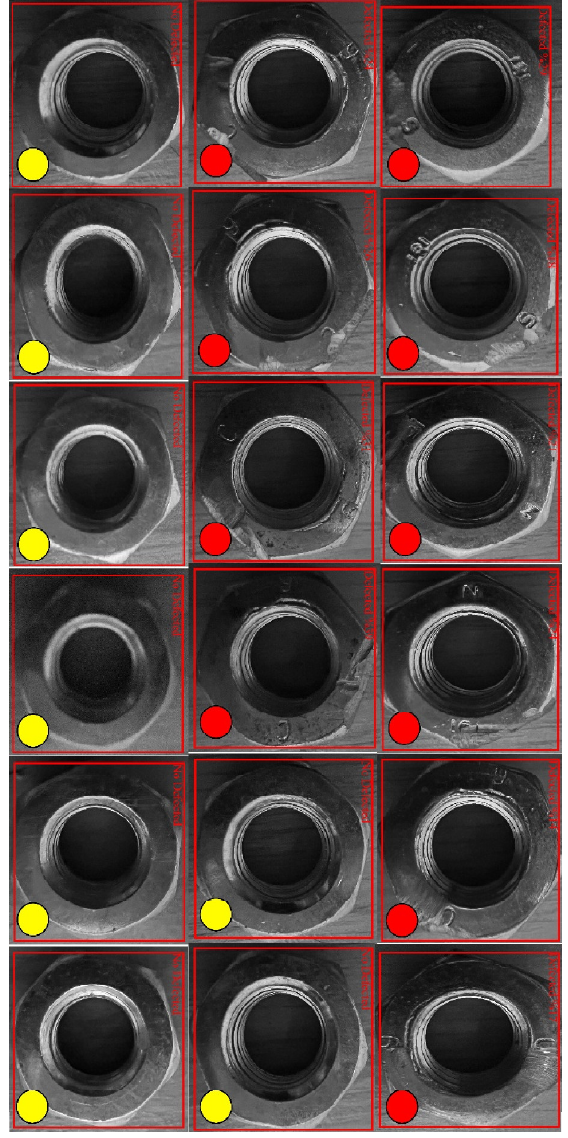
Figure 14. Detection results of faulty and defect-free parts were compared.